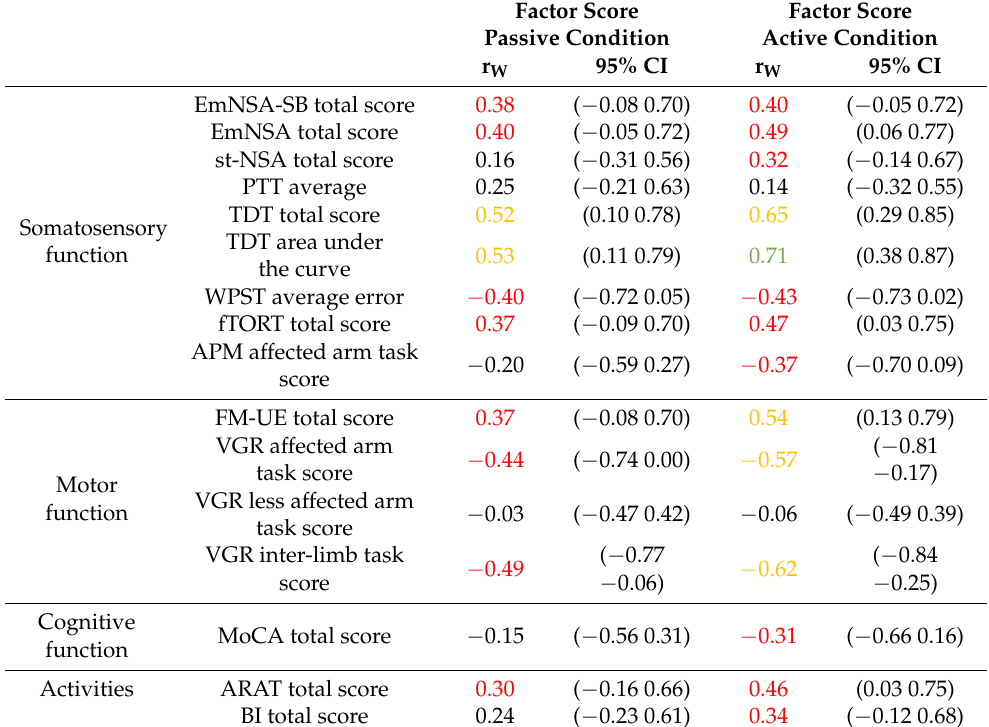
Table 5. Correlation coefficients between factor scores of the robot-based sensory processing tasks, and clinical and robot-based assessments of somatosensory function, motor function, cognitive function and